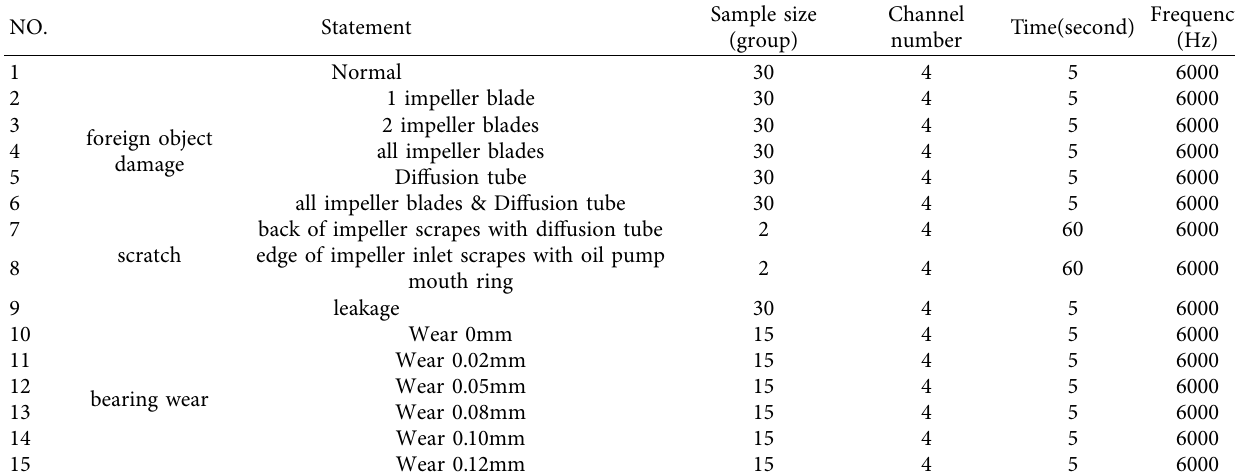
Table 2: Scheme of fault injection test.